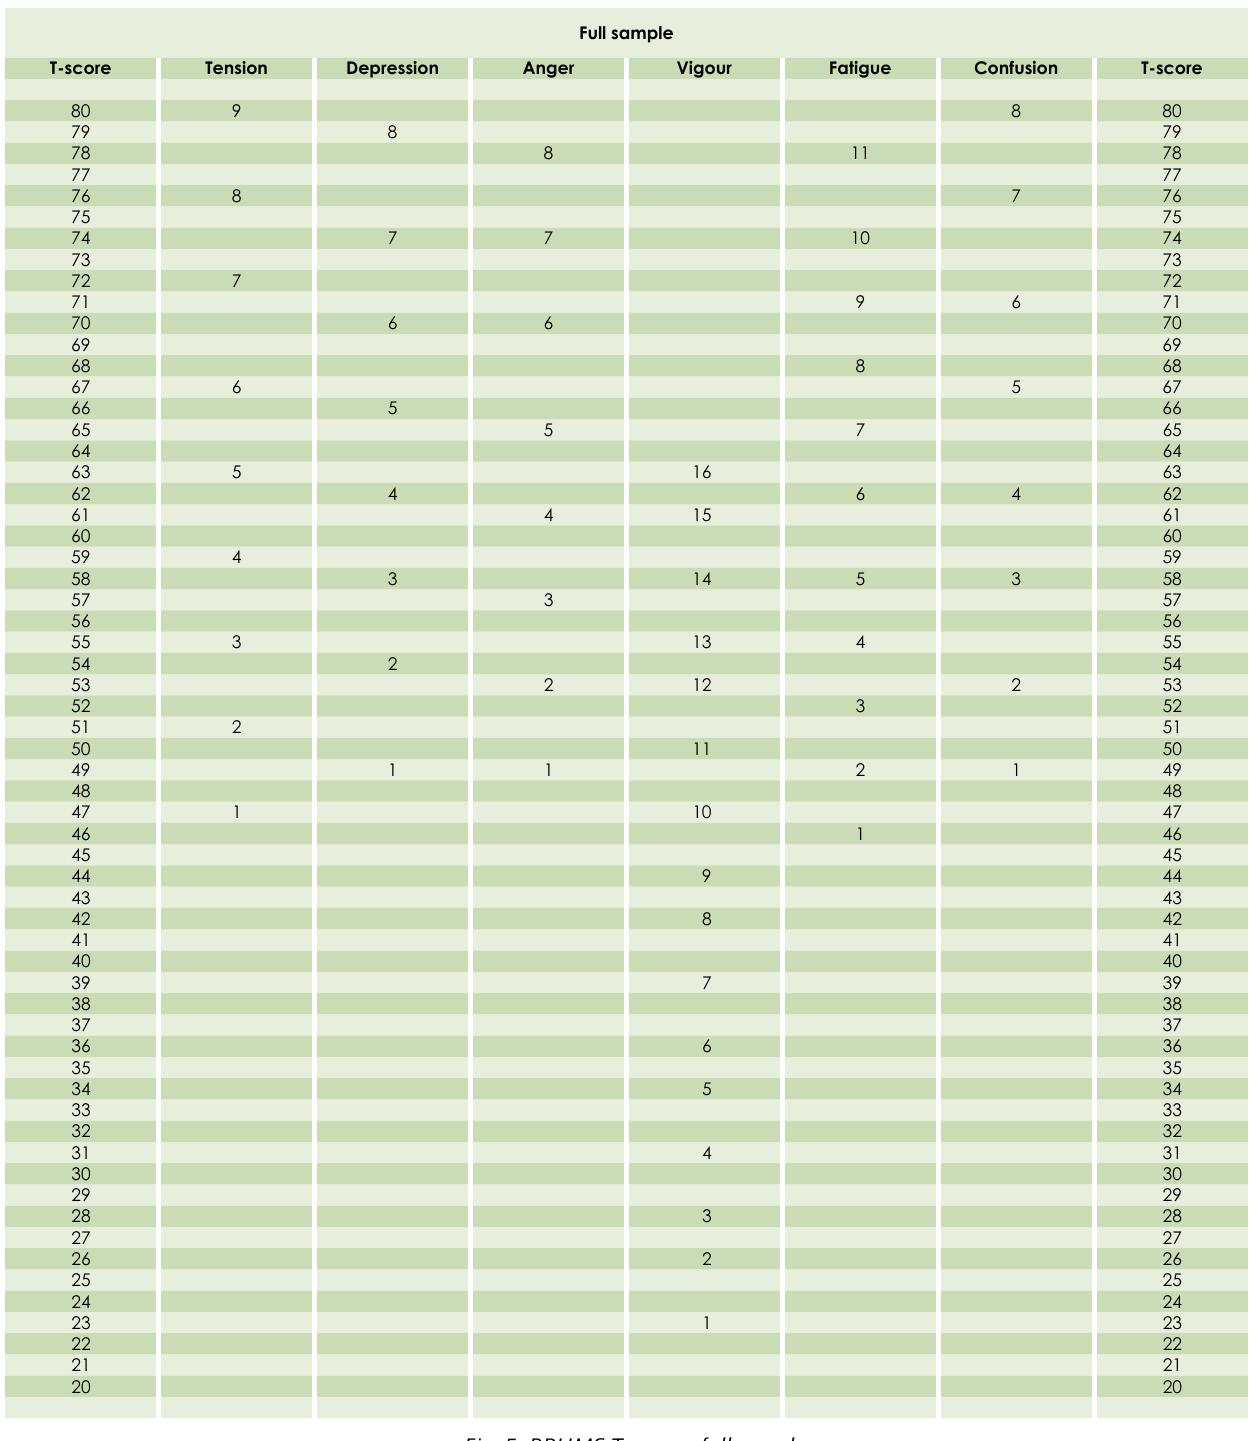
Fig. 5. BRUMS T-scores, full